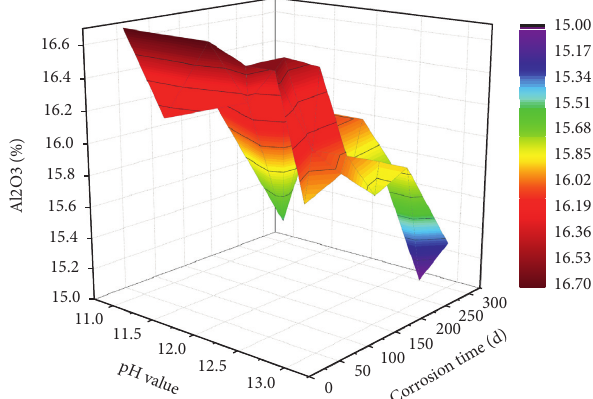
Figure 8: Changes of the Al 2 O 3 content in the laterite at different alkaline-solution concentrations and permeation times.